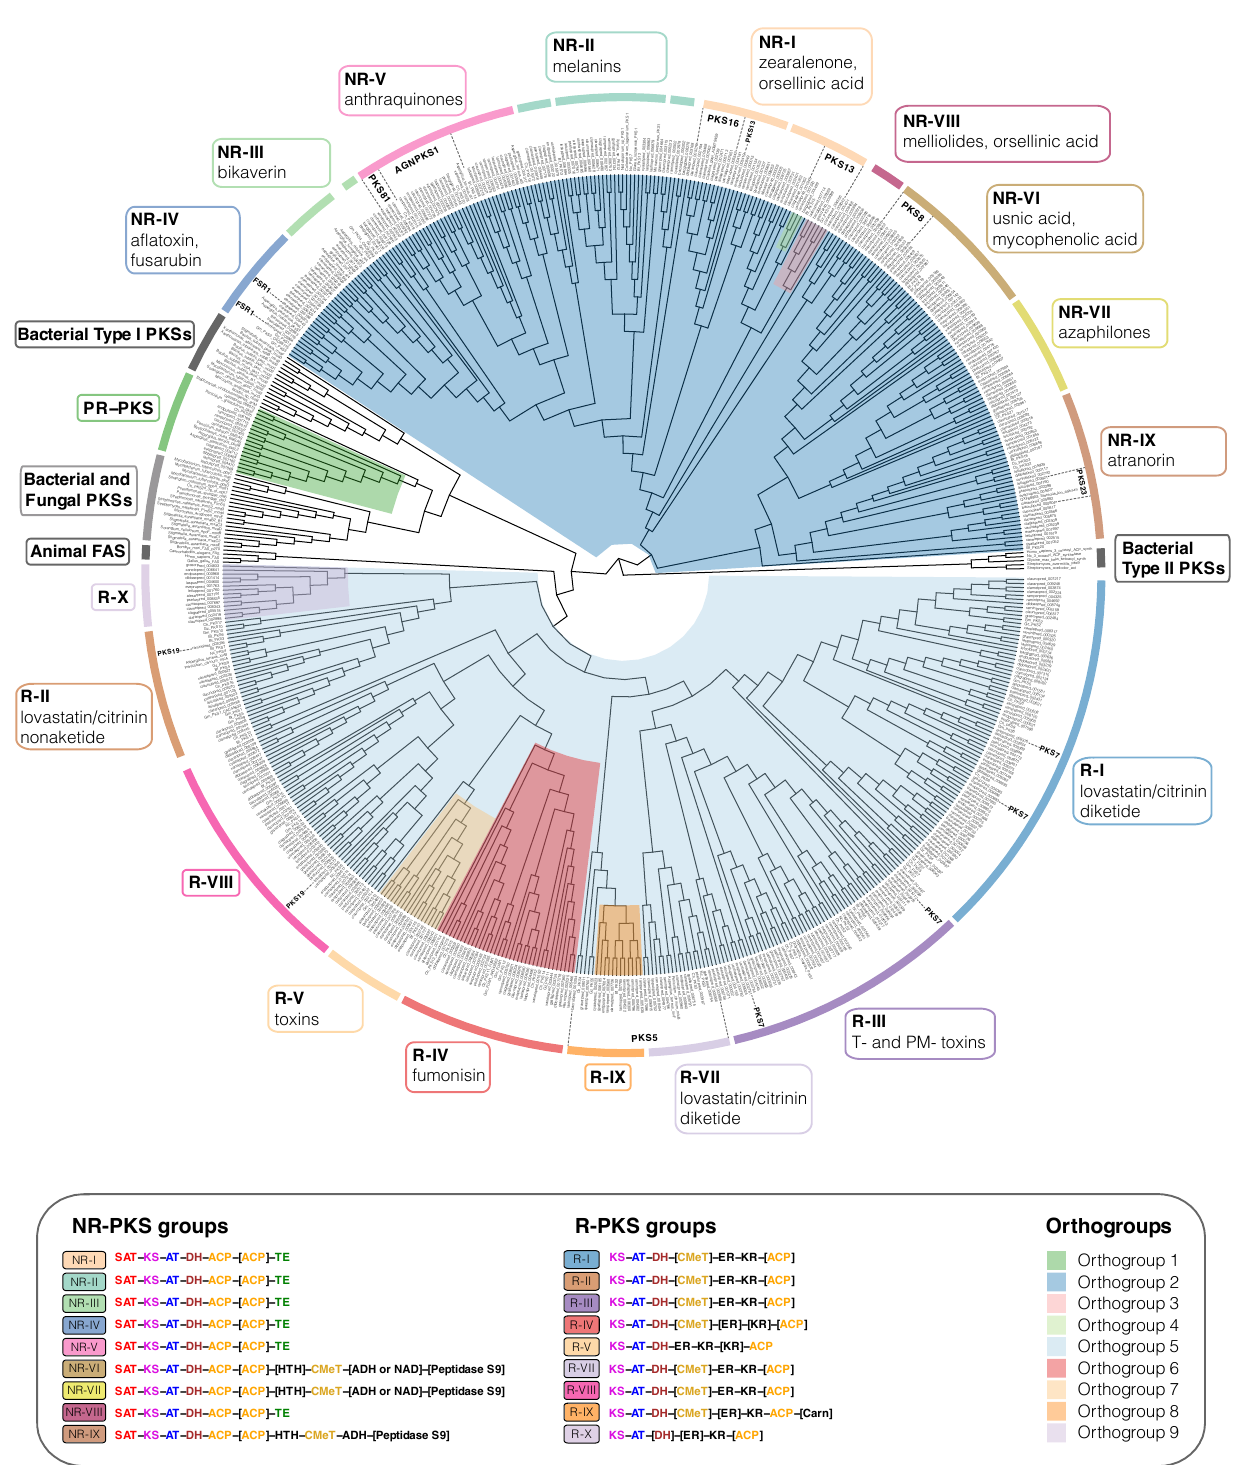
Figure 3. Maximum-likelihood phylogeny of Type I PKS genes inferred by IQ-TREE using Type II Bacterial PKSs as outgroup. Clades containing lichen-forming fungi are highlighted and the corre- sponding Orthogroups (1 to 9, respectively) are indicated by different colors. PR-PKS